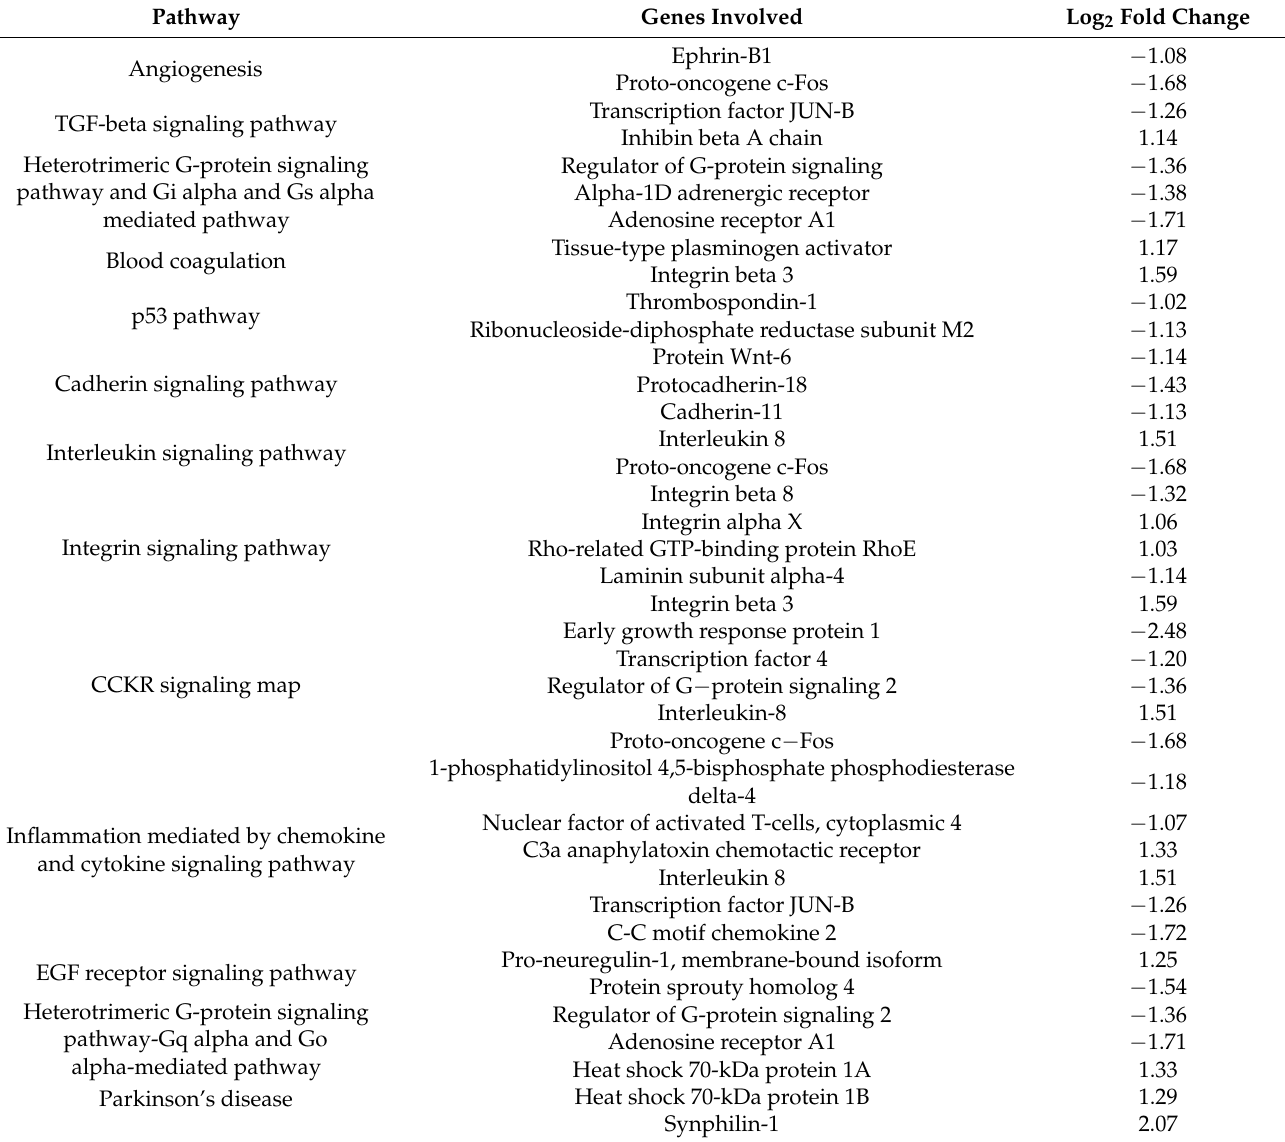
Table 6. Molecular pathways altered in the T98G human glioblastoma exposed for 72 h to 20 µ g/mL of TiO 2 -NPs. Pathway Genes Involved Log 2 Fold Change Ephrin-B1 − 1.08 Angiogenesis Proto-oncogene